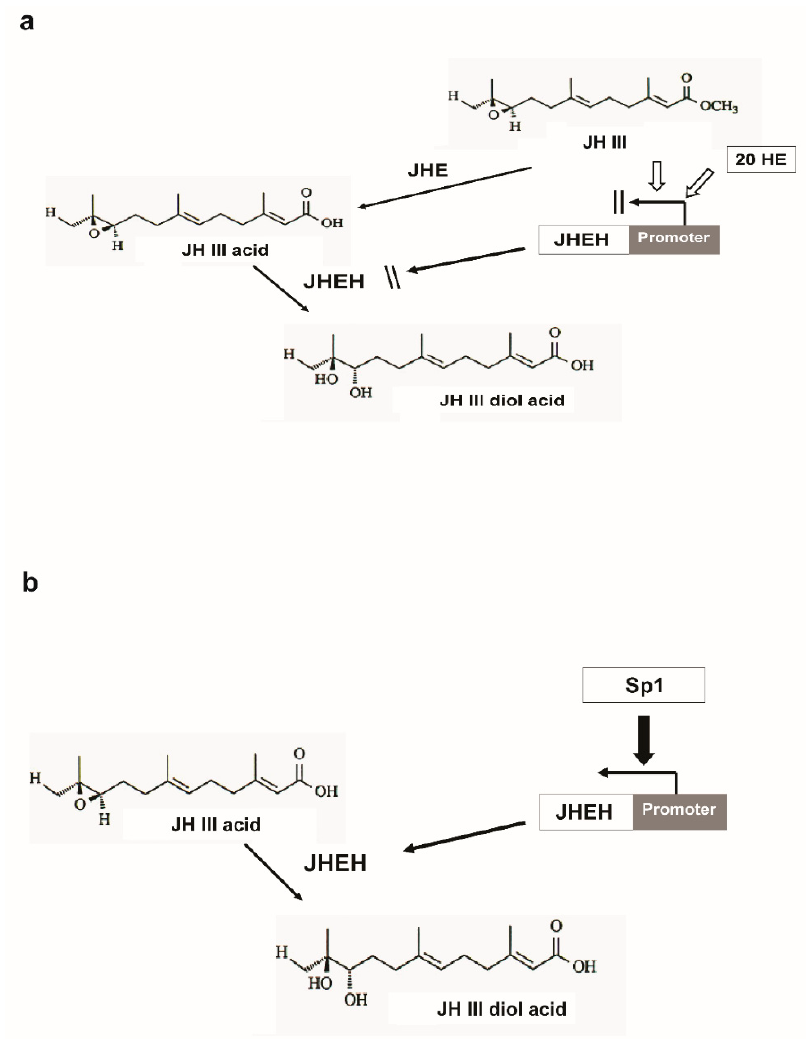
Figure 13. Degradative steps in JH III pathway. ( a ) JHEH promoter is inhibited by high titers of JH III and 20HE. During this time, JHEH is not synthesized. ( b ) After JH III is converted into JH IIIA (JH III acid) by JHE, the JHEH promoter is upregulated by TF Sp1, allowing the synthesis of JHEH, which converts JH IIIA into JH IIIAD (JH III acid diol).